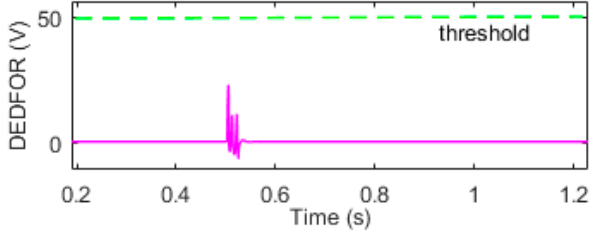
Figure 10. Case 4: Output of the proposed DEDFOR filter under motor starting condition.